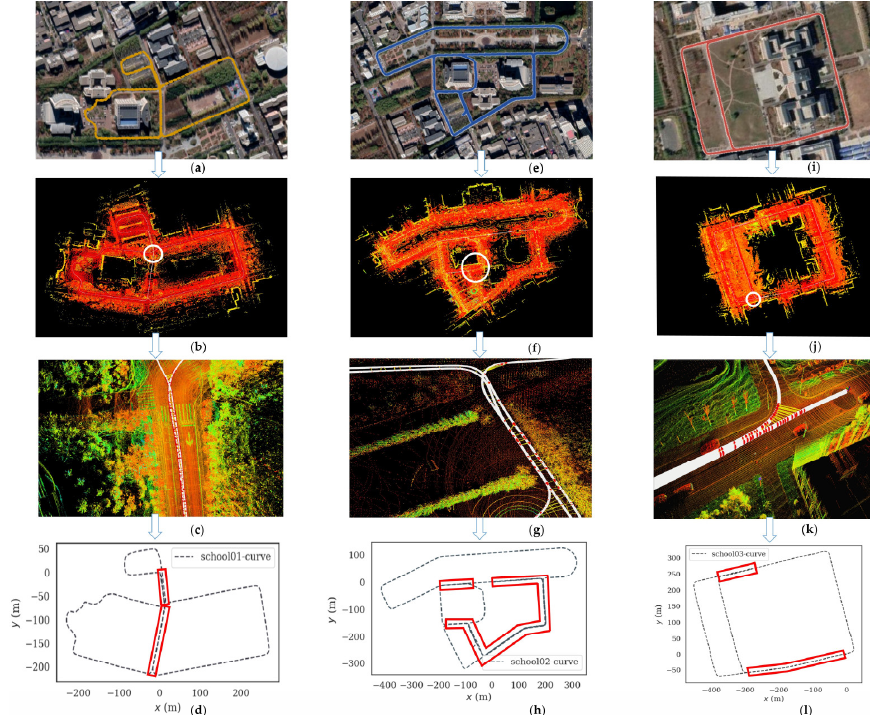
Figure 12. Application of 3PCD-TP in SLAM. ( a ) BV images of School-01; ( b ) Point cloud map of ( a ); ( c ) Enlarged figure circled in ( b ); ( d ) Actual trajectory diagram of ( a ); ( e ) BV images of School-02; ( f ) Point cloud map of ( e ); ( g ) Enlarged figure circled in ( f ); ( h ) Actual trajectory diagram of ( e ); ( i ) BV images of School-03; ( j ) Point cloud map of ( i ); ( k ) Enlarged figure circled in ( j ); ( l ) Actual trajectory diagram of ( i